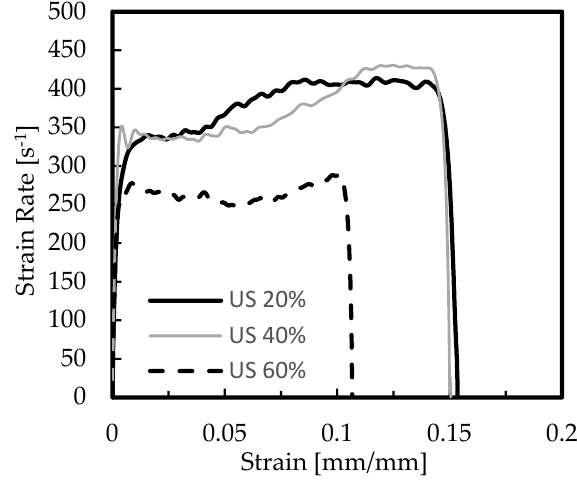
Figure 6. Strain rate-strain curves for the AlSi12 foams.